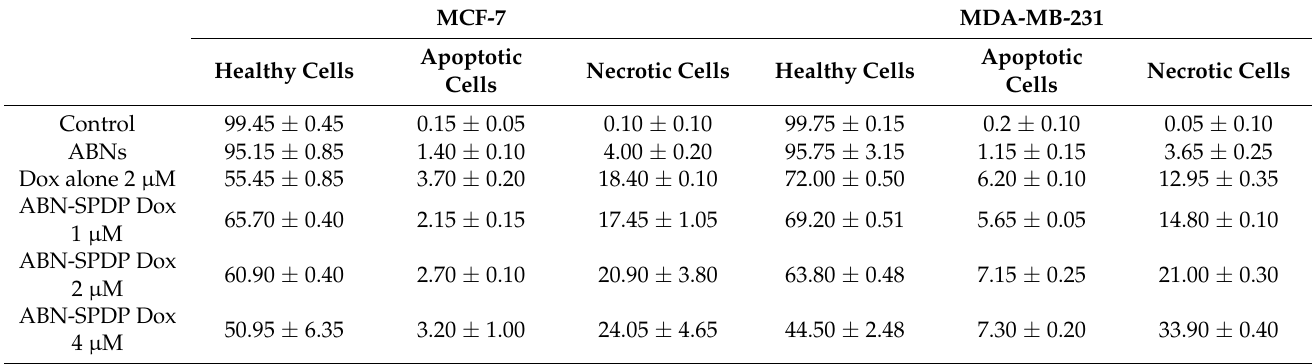
Table 1. Percentage of healthy, necrotic, and apoptotic cells with varying concentrations of Dox-loaded ABN-SPDP 24 h post-treatment in MCF-7 and MDA-MB-231